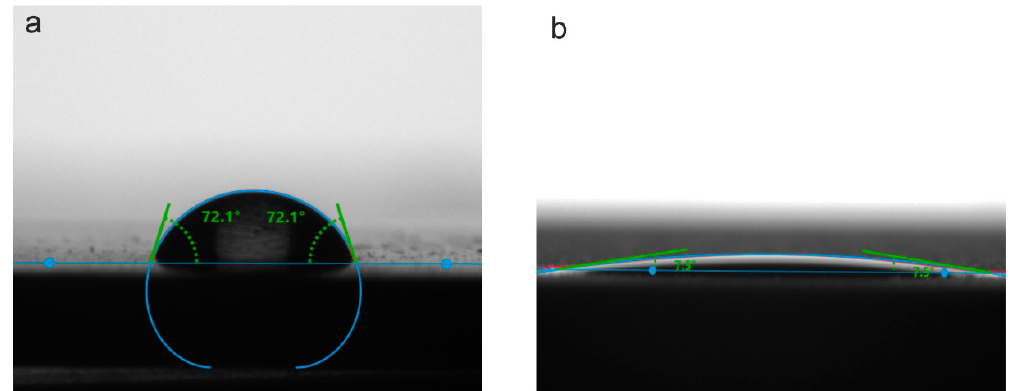
Figure 11. Drops form and contact angle values for uncoated sample ( a ) and sample with a PEO- coating ( b ) Test liquid is